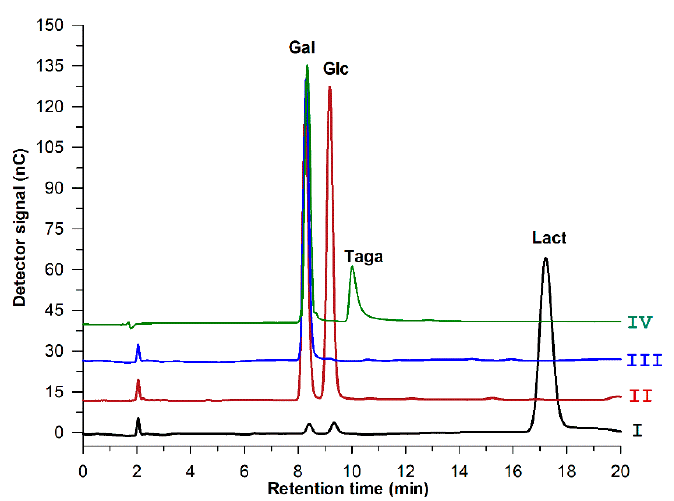
Figure 6. HPAEC-PAD chromatograms showing the bioconversion of whey permeate into D -tagatose syrup. (I) Original whey permeate; (II) After treatment with β -galactosidase from B. bifidum ; (III) After removal of glucose with P. pastoris cells; (IV) After isomerization with of L -arabinose isomerase US100. Gal: D -Galactose; Glc: D -glucose; Taga: D -tagatose; Lact: D -Lactose .